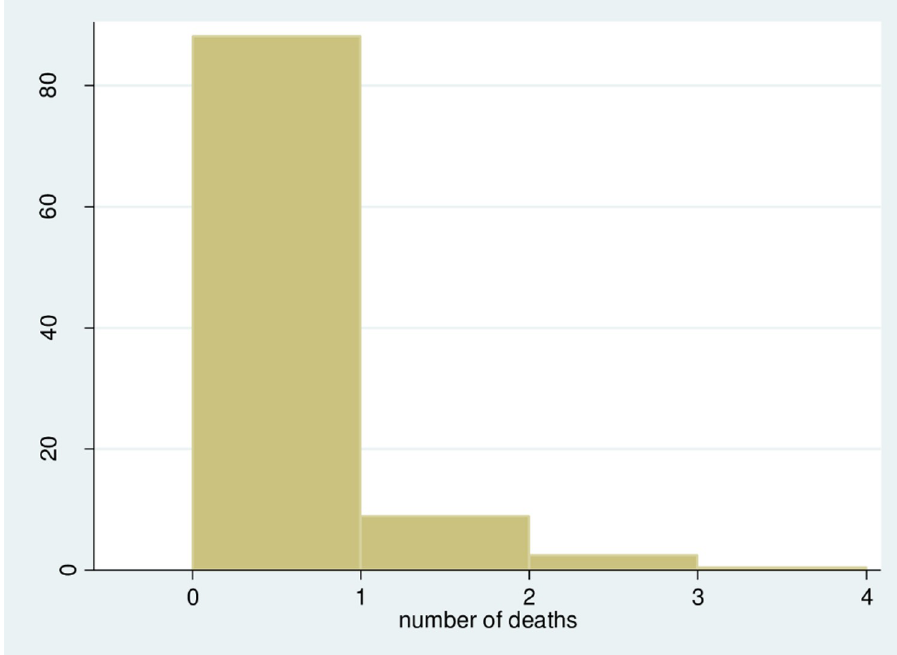
Fig 2. Hostogram of the number of under-five deaths per